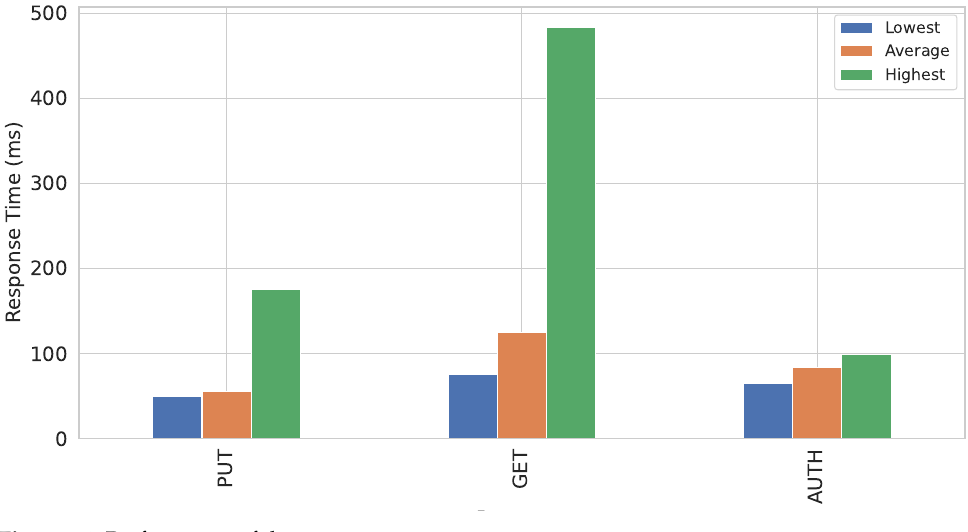
Figure 14. Performance of the resource